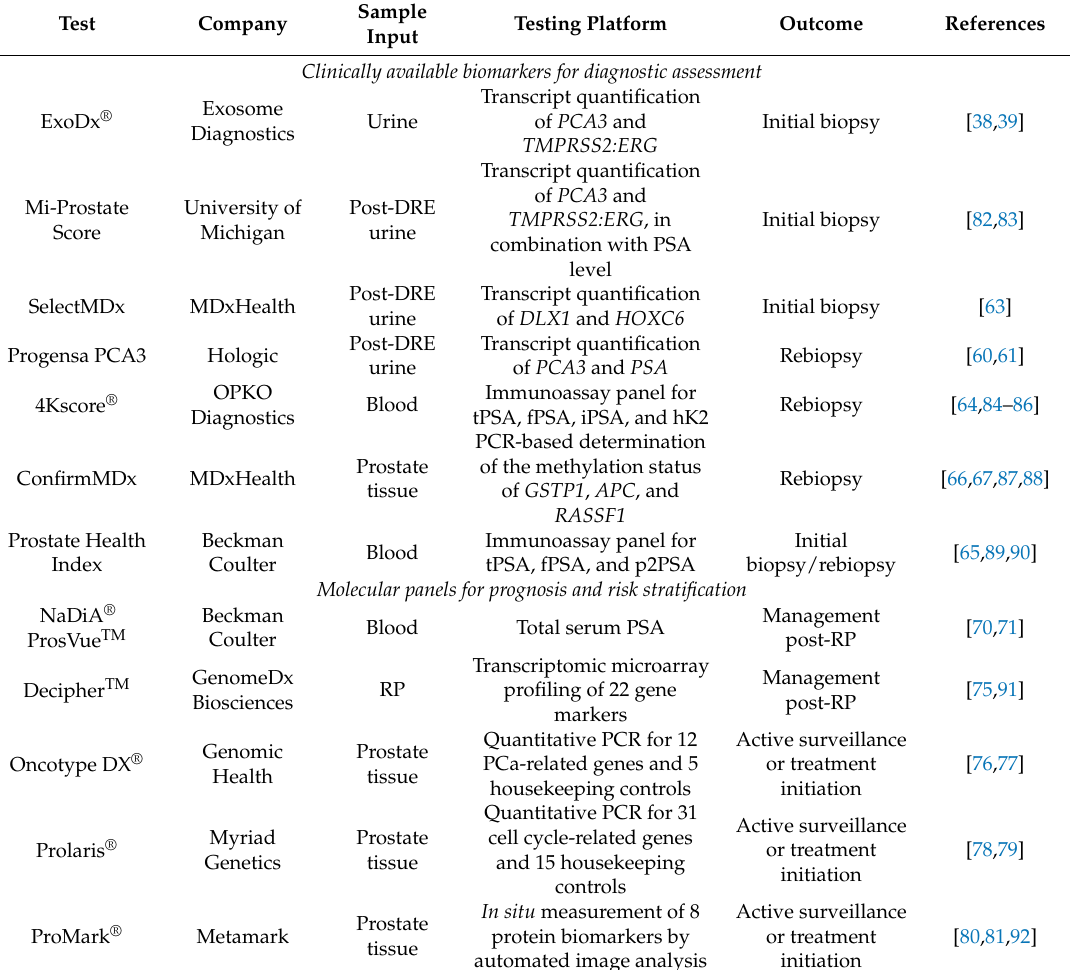
Table 1. Prostate cancer diagnostic and prognostic